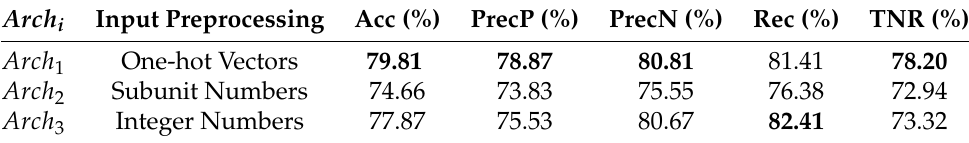
Figure 8. Test accuracies according to input preprocessing type: Arch 1 —One-hot Vectors (orange), Arch 2 —Subunit Numbers (blue), and Arch 3 —Integer Numbers (red). Table 4. Results of three input preprocessing approaches on the testing dataset.